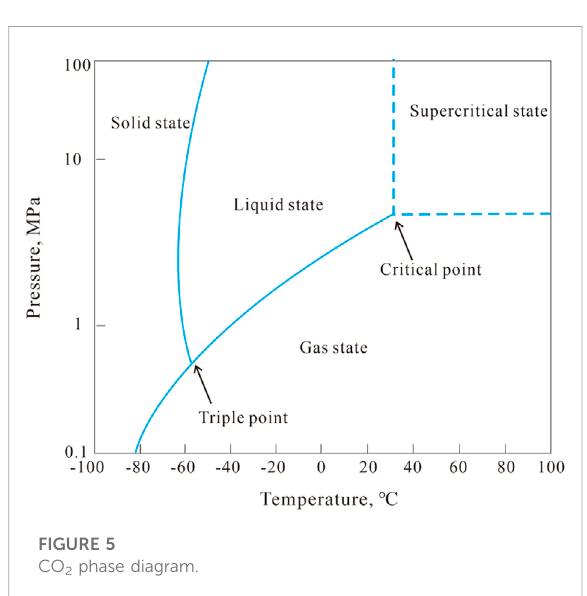
FIGURE 5 CO 2 phase